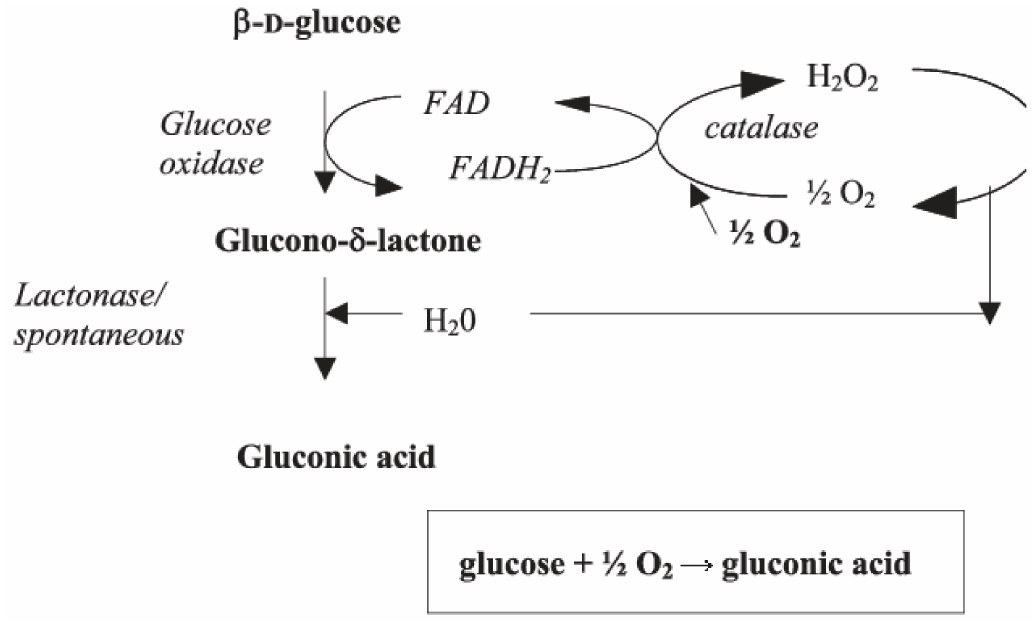
Figure 1. Oxidation of glucose by glucose oxidase (Reprinted from Ref.